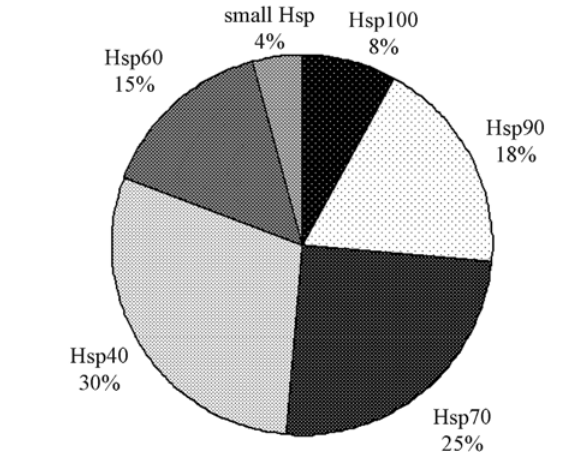
Figure 2 - Relative abundance of the chaperone families in Eucalyptus . The number of reads of each chaperone family was normalized as the per- centage of the total chaperones annotated. The Hsp60 family slice repre- sented here also contains the Hsp10 family, which represented nearly 2% of all annotated chaperones in FORESTs.